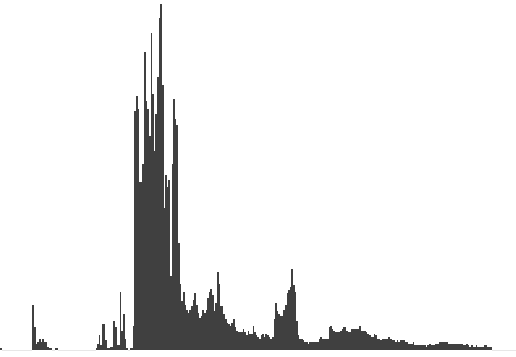
Figure 5: Distance histogram of all points on a single street-side for a given track segment.